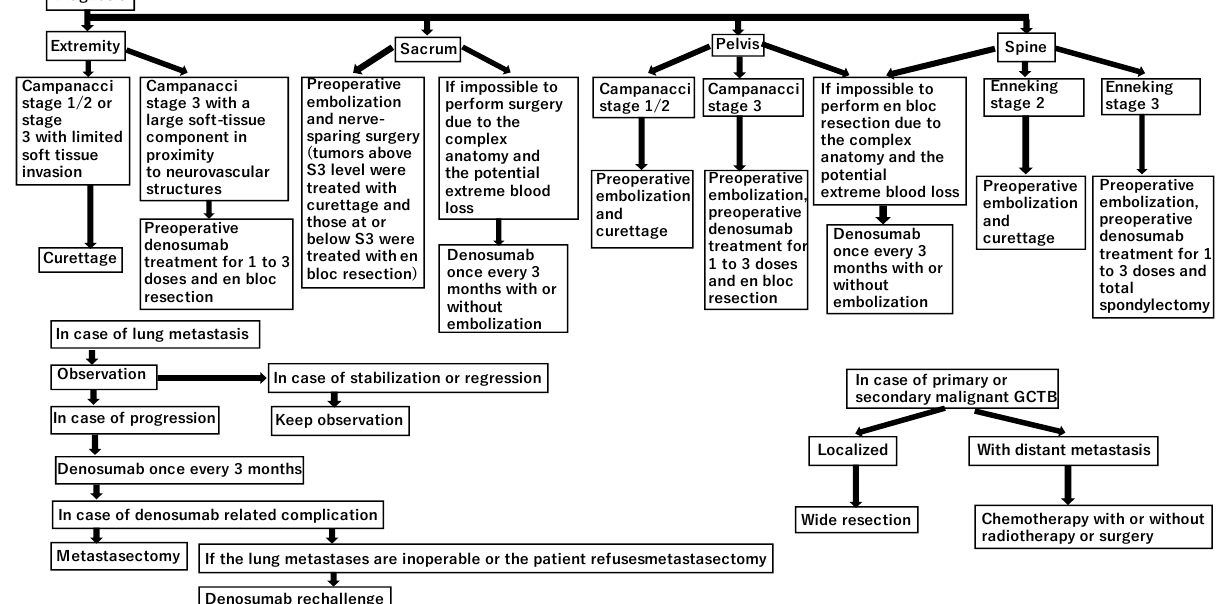
Figure 1. Treatment algorithm for giant cell tumors of the bone. GCTB: giant cell tumor of bone.